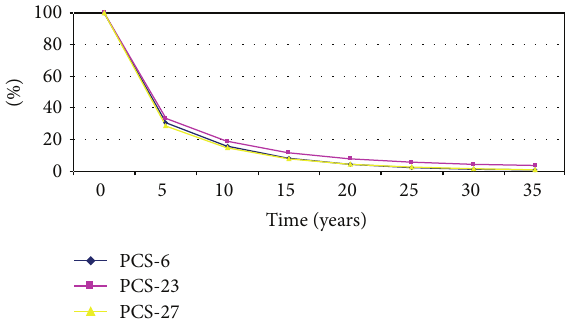
Figure 7: Variation of dose rate of some PCS components over